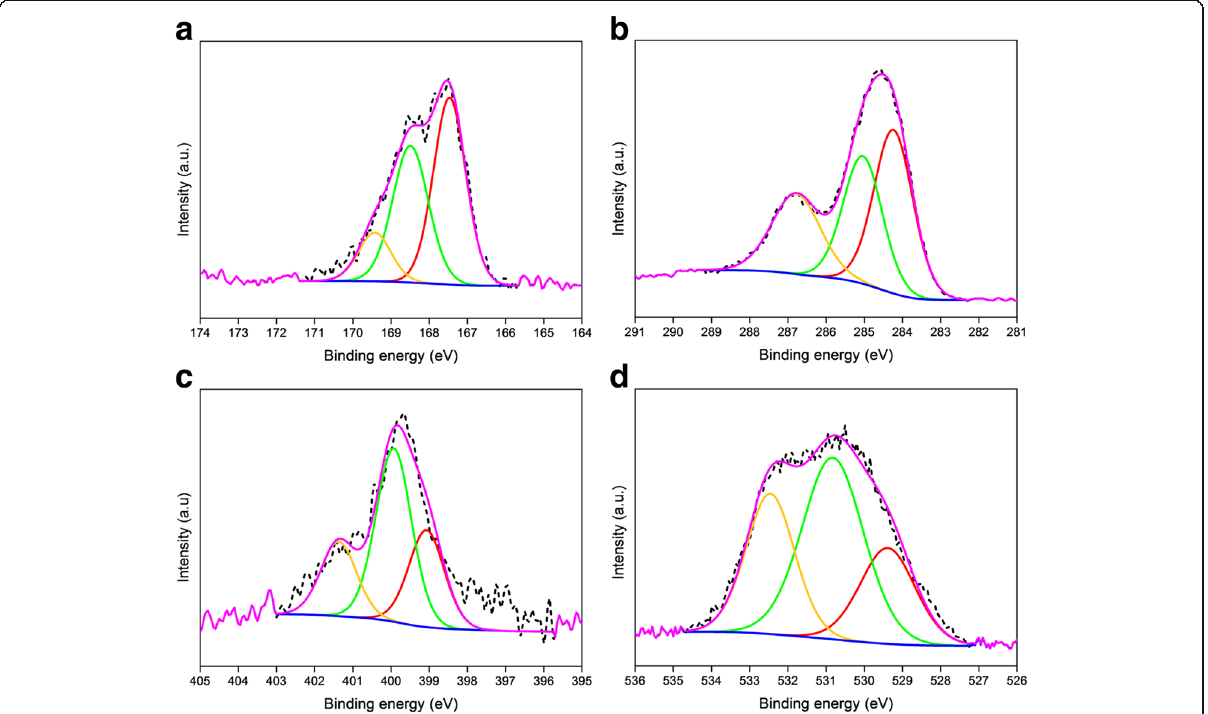
Fig. 4 XPS core-level spectra of PPy-rGO-2 nanocomposite and corresponding deconvolutions of a S2p, b C1s, c N1s and d O1s states. Dotted lines show raw data, and solid lines are fitting